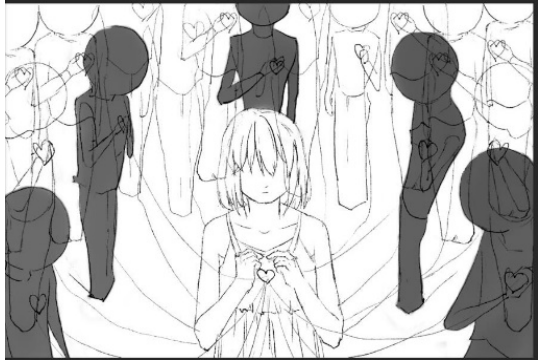
Figure 6. The end-game